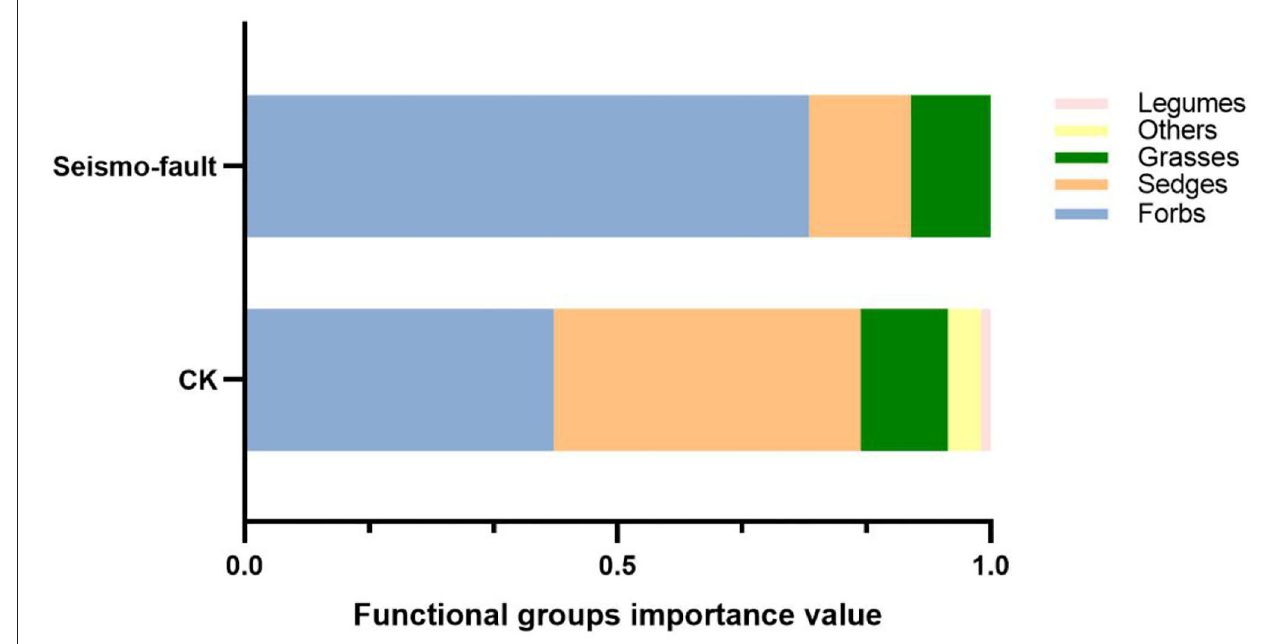
FIGURE 3 | The importance values of functional groups in different seismic regions.